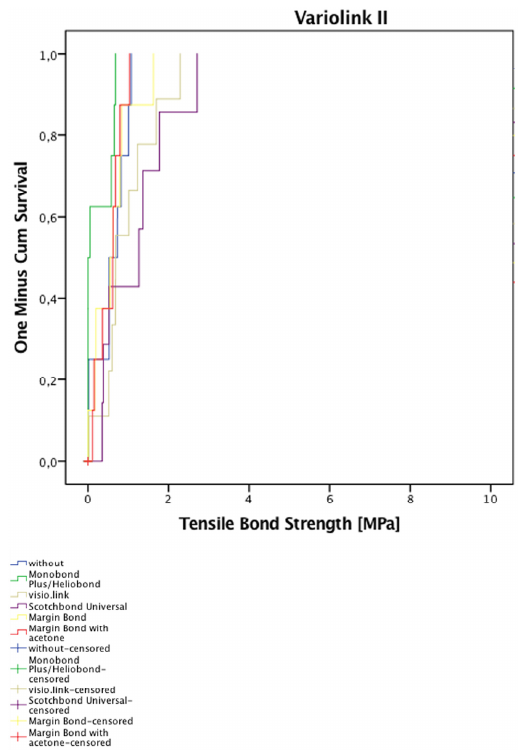
Figure 4. Estimated cumulative failure functions of specimens bonded with Variolink II. Table 4. Median survival tensile strength (MPa) and 95% confidence interval of survival in all test groups.